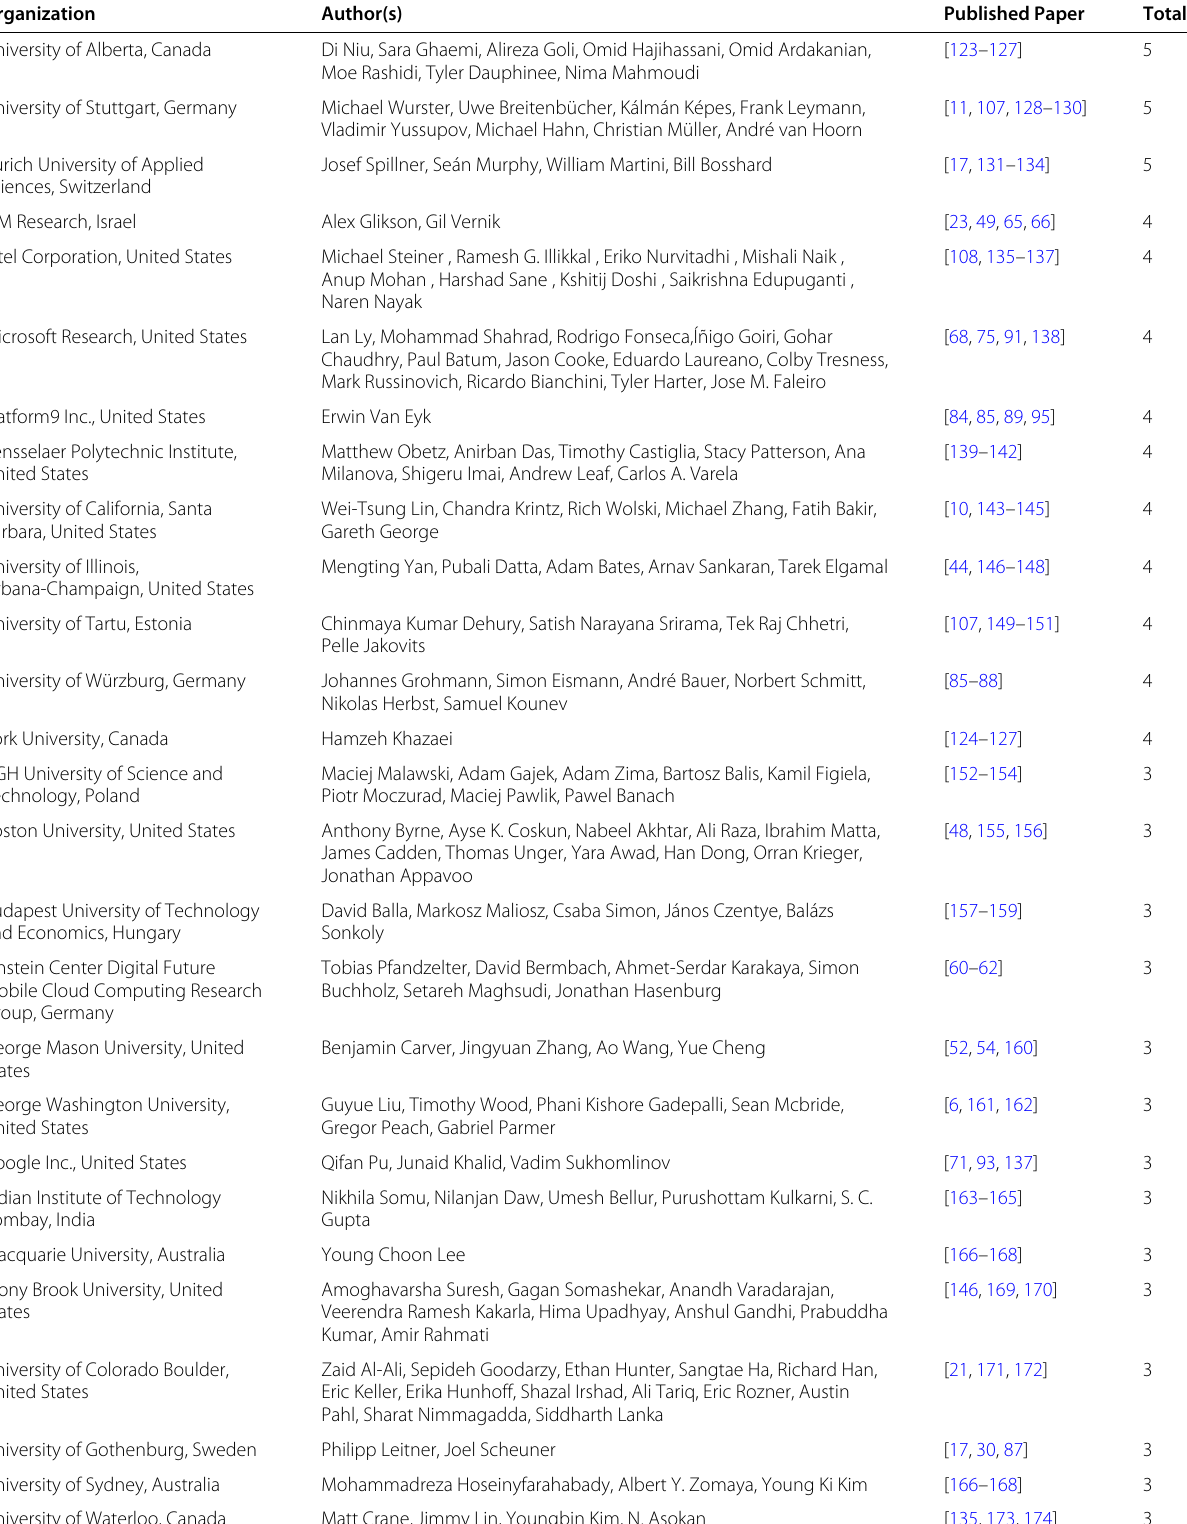
Table 4 Organizations, and researchers active in researching serverless computing